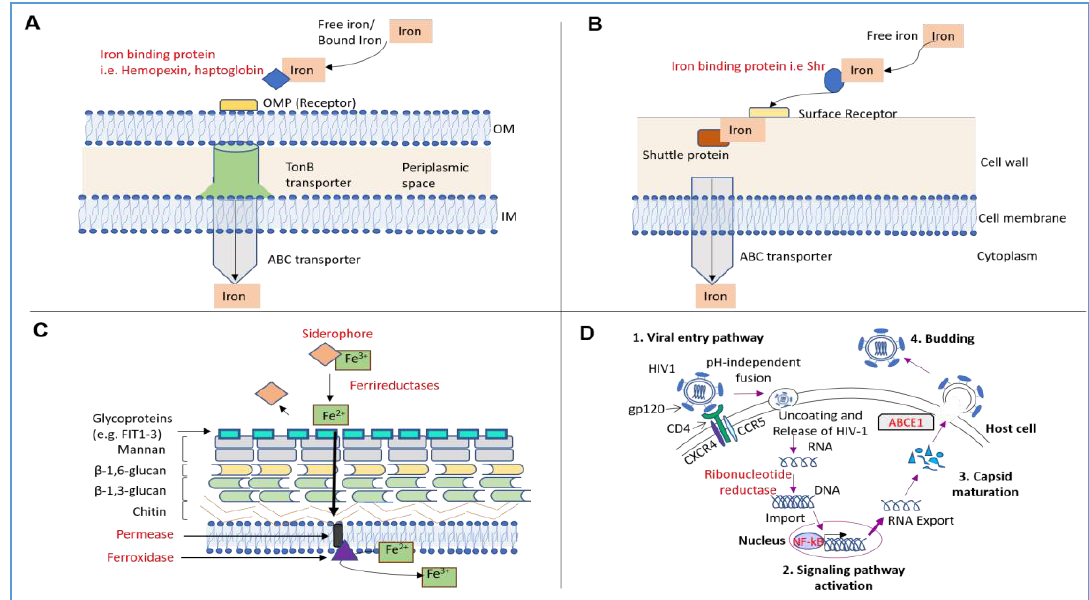
Figure 1. Mechanisms of Iron Acquisition in Bacteria and Fungi as well as Mechanisms of Iron Utilization in Viruses. ( A ) In Gram-negative bacteria, the iron acquisition involves uptake of free iron from the extracellular environment. Specific proteins that bind heme or hemoglobin (e.g., hemopexin or haptoglobin) are secreted from the bacteria, to then bind to free iron or heme [36]. These complexes then interact with outer membrane protein (OMP) receptors on the surface of the outer membrane (OM) of the bacterial cell wall [37]. The iron is then moved to the TonB–dependent receptor complex [36]; after the iron reaches the ABC transporter, it finally passes the inner membrane into the bacterial cytoplasm [37]. ( B ) In Gram-positive bacteria, secreted specific iron/heme binding proteins interact with heme [37], following which, the iron binding protein localizes to the surface of the bacterial cell wall to bind to a specialized cell surface receptor [38]. Next, specific permeases enable the translocation of this complex across the bacterial cell wall [39]. The iron-bound molecule is subsequently transferred to a shuttle protein that then guides the iron into the ABC transporter, an integral membrane protein [39]. The ABC transporter translocates the iron-bound molecule into the bacterial cytoplasm [39]. ( C ) In fungi, the iron uptake system involves reductive and/or non-reductive mechanisms [40]. In the reductive iron assimilation pathway, iron acquisition is initiated via